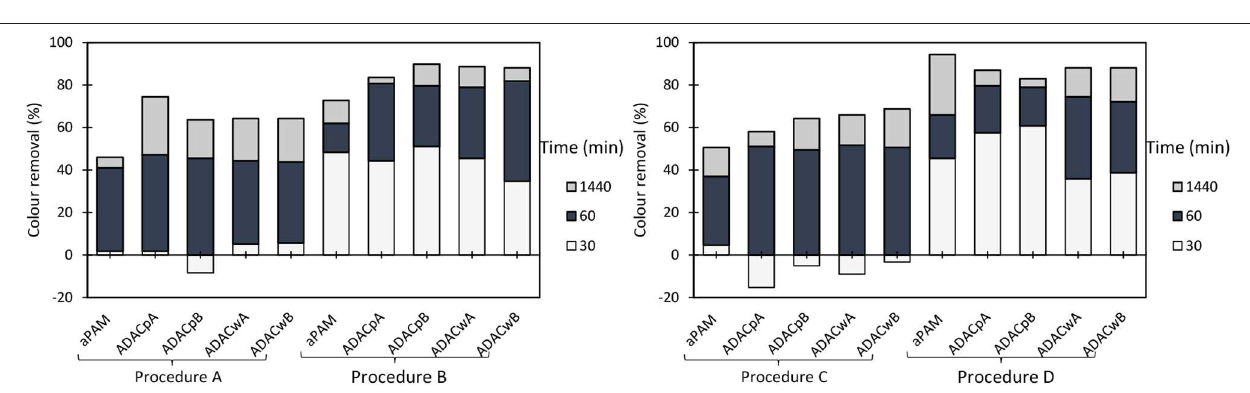
FIGURE 8 | Turbidity removal of industrial effluent as a function of time of settling, using anionic cellulose-based flocculation agents from bleached pulp (ADAC p A and B) and from wood chips (ADAC w A and B), in a dual system with bentonite, at pH 1.5. Procedure A: 0.3 wt% bentonite followed by 2.67 mg/L of flocculant. Procedure B: 0.6 wt% bentonite and 5.34 mg/L of flocculant. Procedure C: 0.3 wt% bentonite and 5.34 mg/L of flocculant. Procedure D: 0.6 wt% bentonite and 2.67 mg/L of flocculant. An anionic synthetic aPAM (in a dual system with the same concentrations described in procedures A-D), was used as